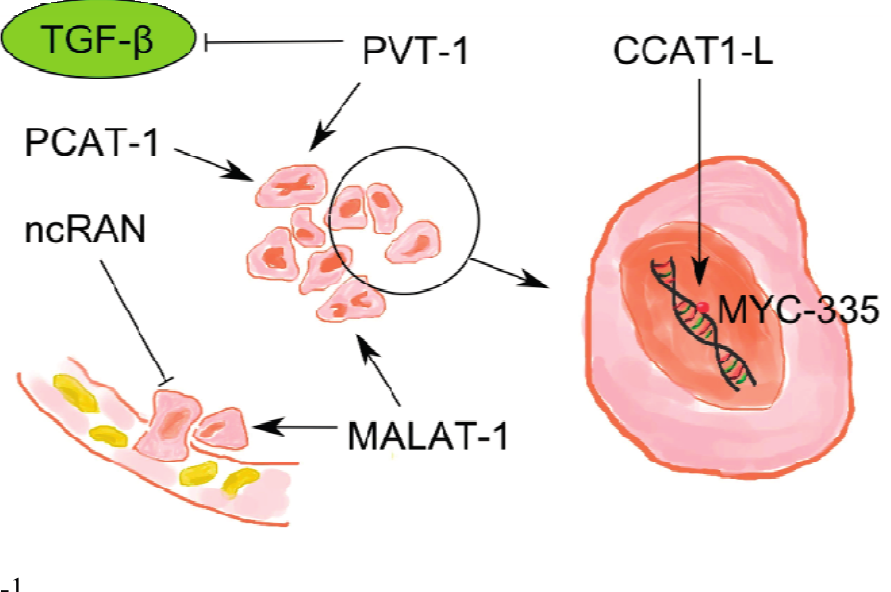
Figure 1. LncRNAs being involved in molecular pathogenesis of colorectal cancer: lncRNAs interact with specific molecular structures, induce different effects in tumor cells and influence the molecular pathogenesis of colorectal